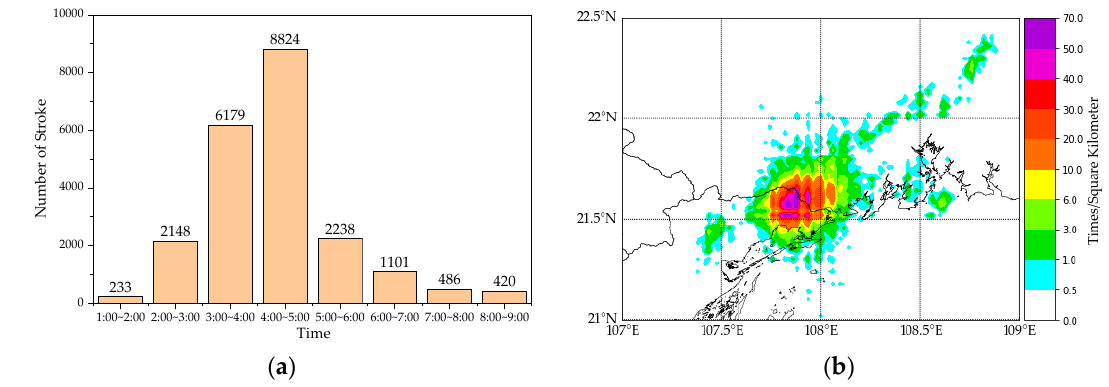
Figure 12. ( a ) Number of strokes detected by APLLN for different hours. ( b ) Stroke density distribution during the thunderstorm (during 1:00 to 9:00 am).